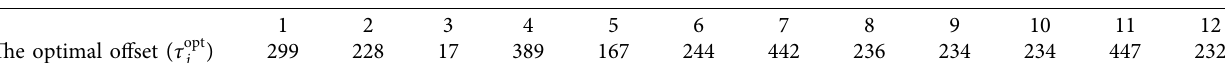
W fra j of j ( n j + τ j